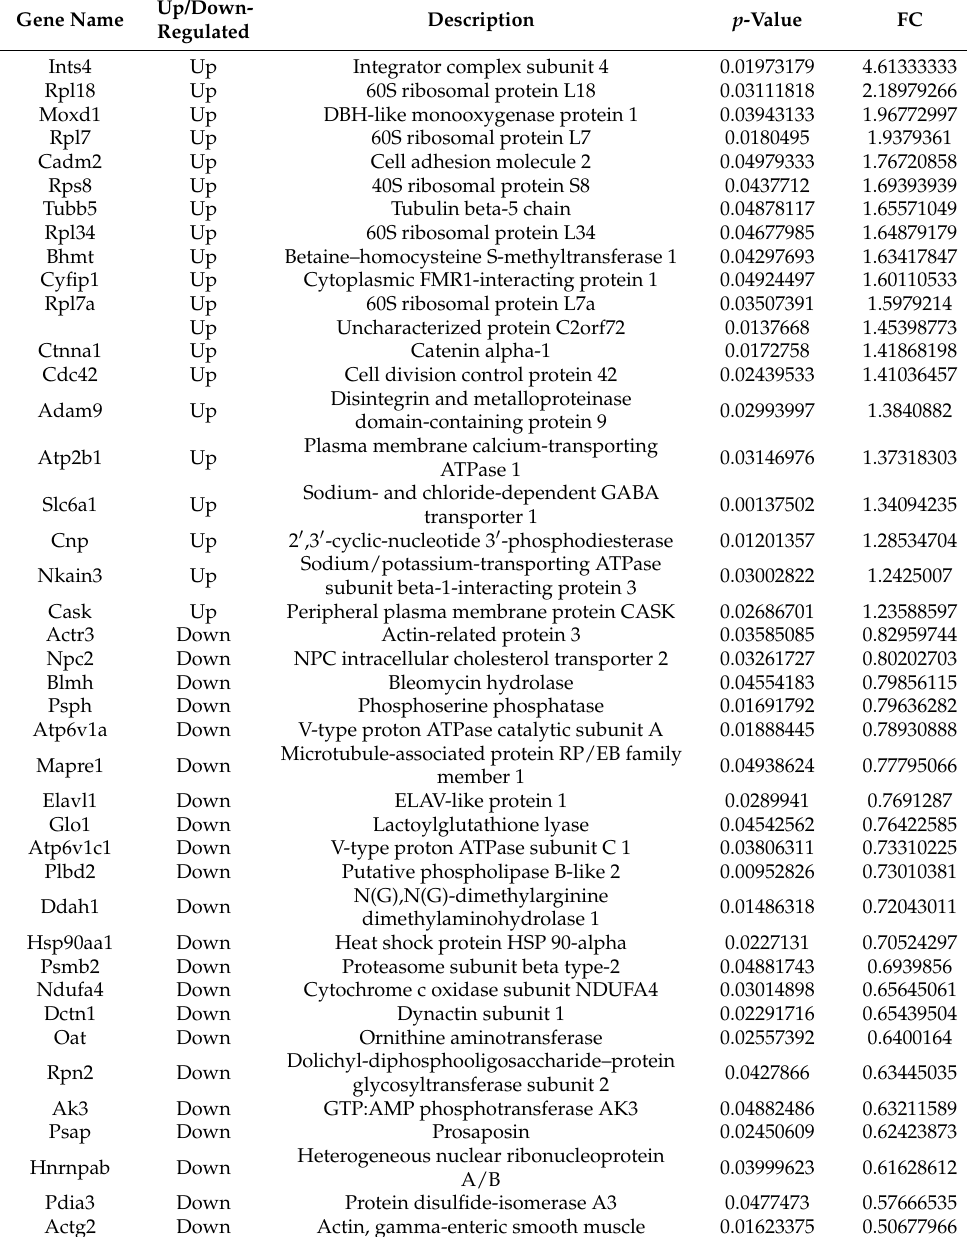
Table 1. The expression levels of differentially expressed